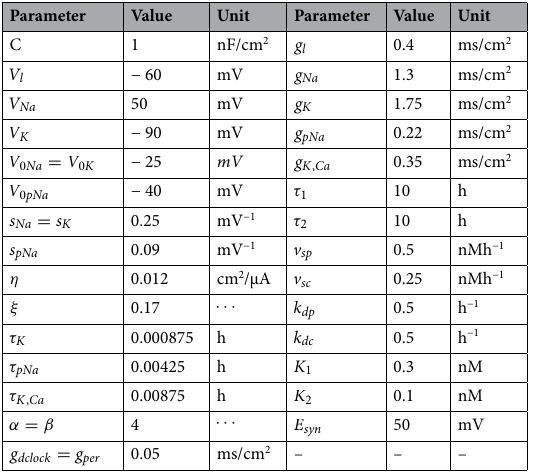
Table 1. The parameters values for the model (1). The parameter values are very similar as proposed in an earlier preliminary study 23,34